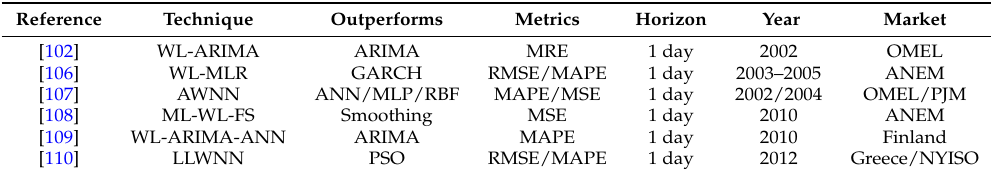
Table 7. Summary on wavelets for electricity